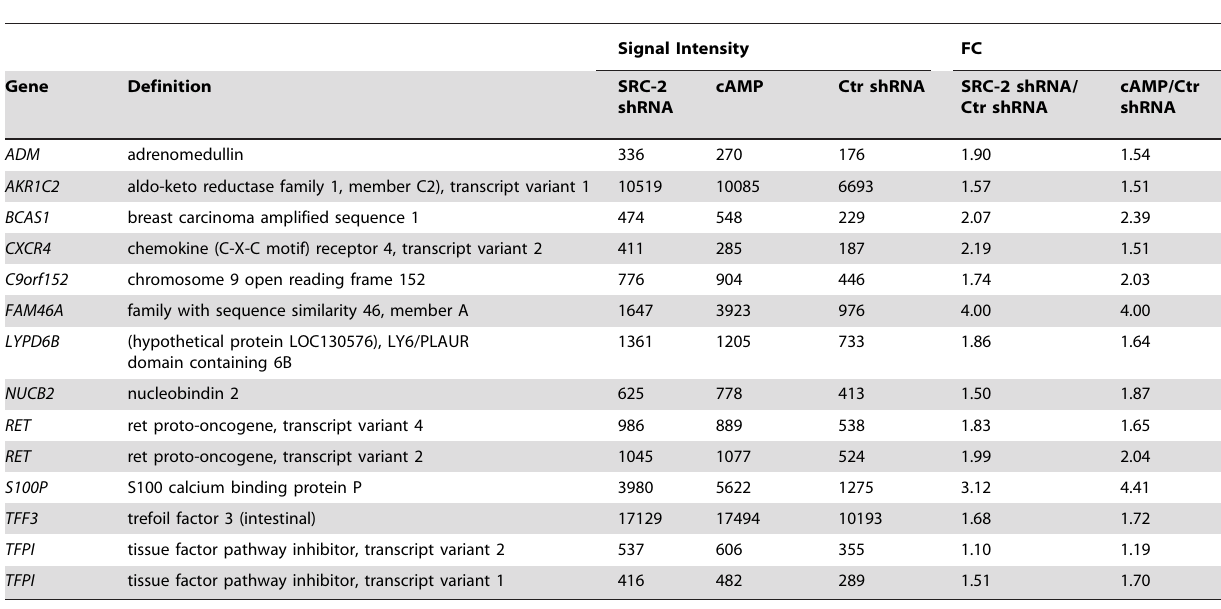
Table 2. Overlapping increased expression changes relative to control induced by SRC-2 KD and cAMP in MCF-7 cells.